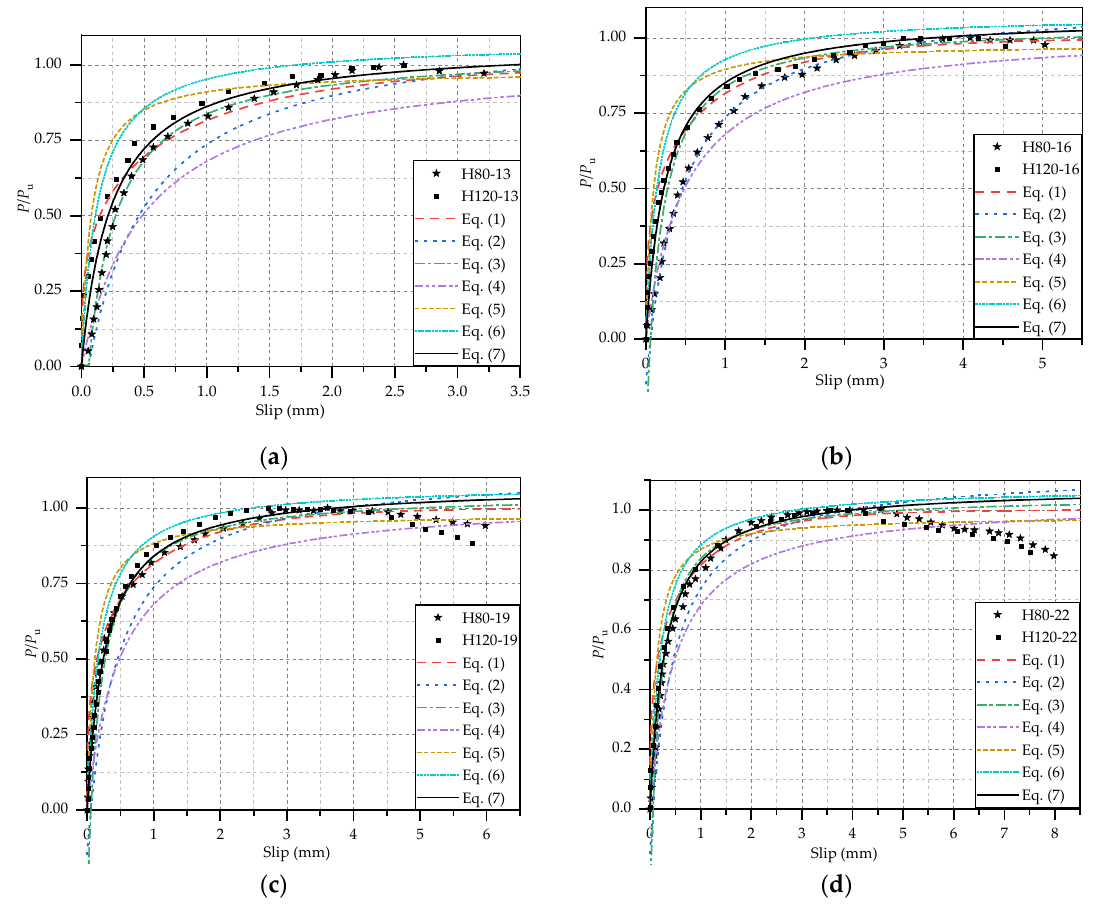
Figure 8. Comparison of experimental and calculated load-slip curves: ( a ) d stud = 13 mm; ( b ) d stud = 16 mm; ( c ) d stud = 19 mm; ( d ) d stud = 22 mm. Table 6. Comparison of load-slip curves obtained by test results and prediction formula.